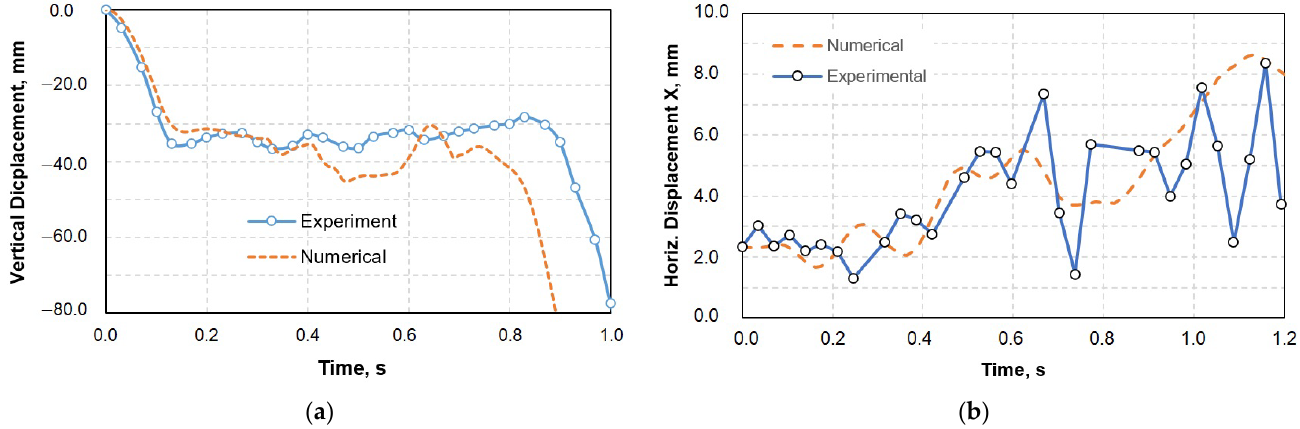
Figure 15. Material models accepted for numerical simulation: CSCM yield surface for concrete ( a ); piecewise linear diagrams for the steel reinforcement ( b ).